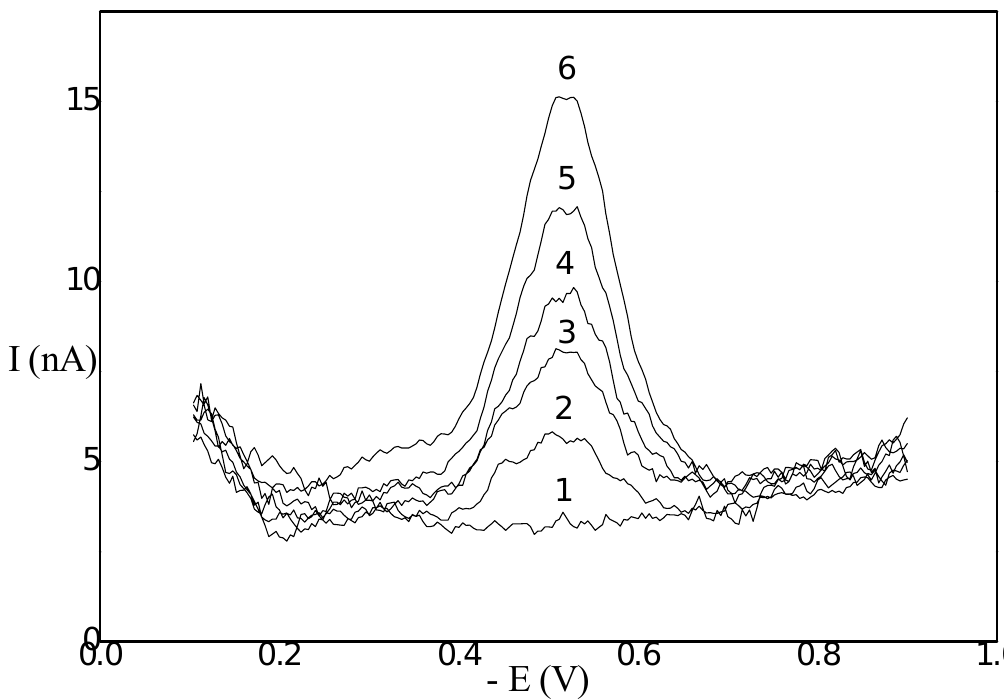
Figure 1. DP voltammograms on HMDE of 6-methyl-5-nitrouracil in Britton-Robinson buffer, pH 7.0 at concentrations 0 (1), 2*10 -7 (2), 4*10 -7 (3), 6*10 -7 (4), 8*10 -7 (5), and 10*10 -7 (6) mol.l -1 .